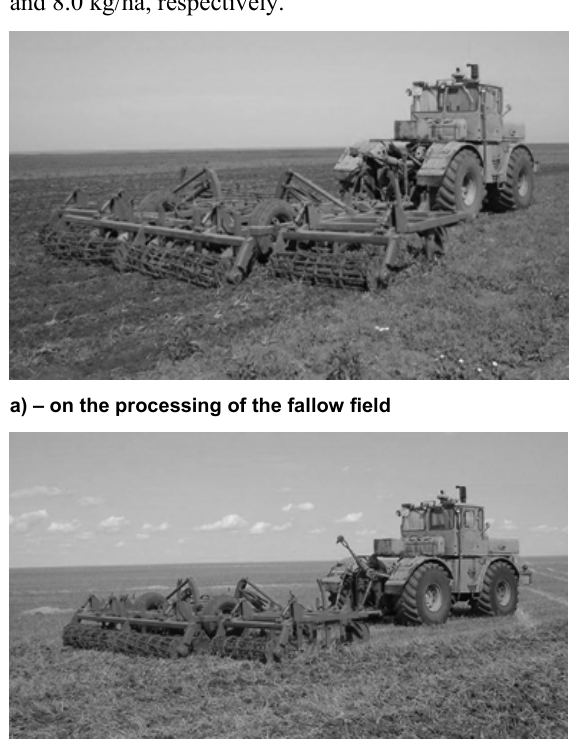
Figure 13. An experimental sample of a combined implement in an aggregate with a K-701